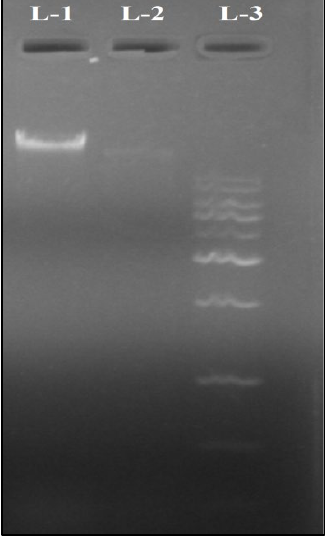
Figure 4. Lane 1- Gut microbial DNA of larvae unfed with antibiotic, lane 2- larvae fed with antibiotic and lane 3- DNA ladder